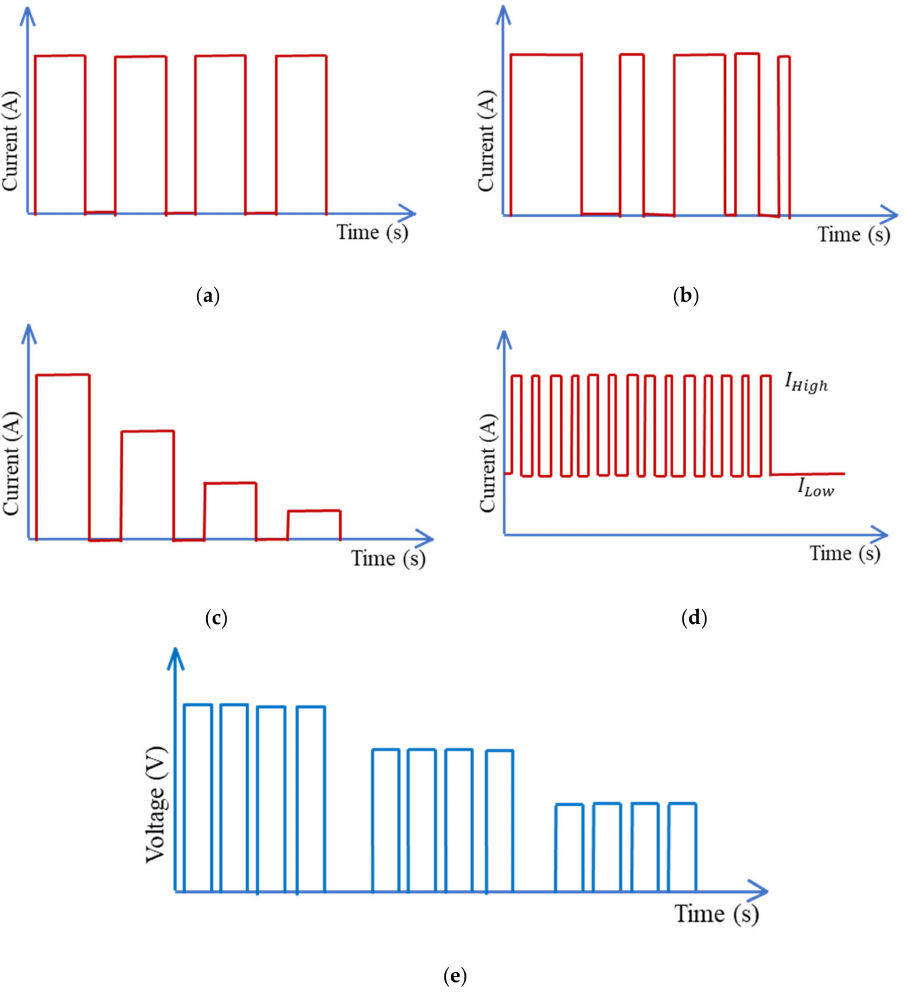
Figure 7. Types of the Standard Positive Pulsed Charging Current (PPCC) Protocol; ( a ) standard protocol with equal duty cycle, ( b ) standard protocol with various duty cycle, ( c ) standard protocol with decaying current, ( d ) standard protocol with upper and lower current limit, and ( e ) different pulse-charge